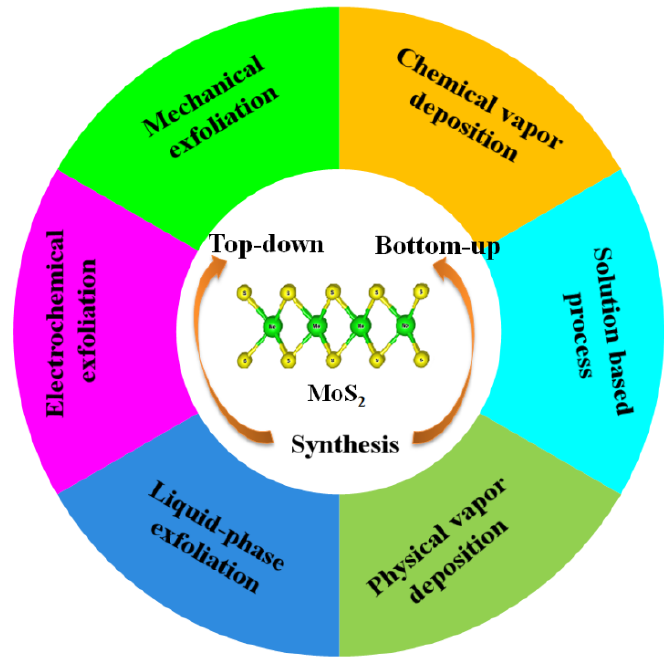
Figure 3. Various synthetic methods for MoS 2 preparation.